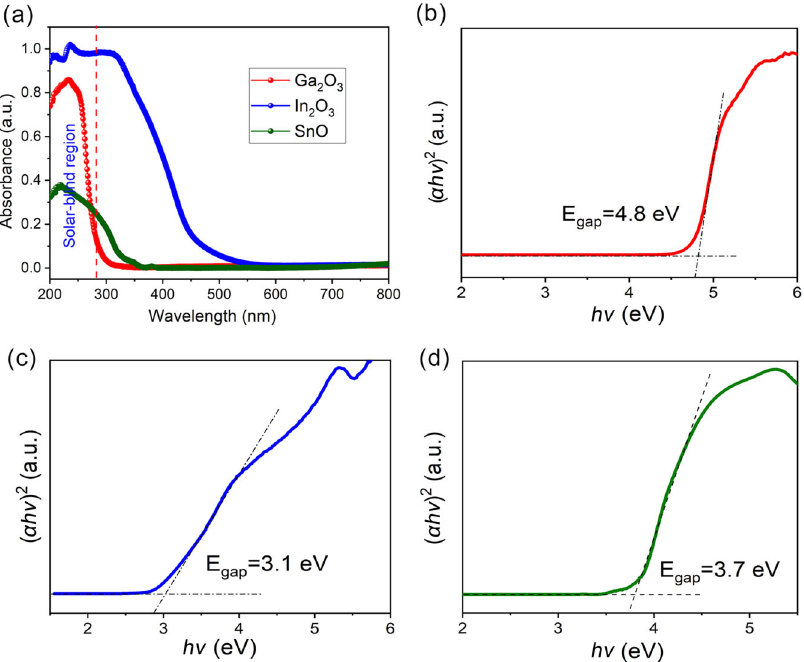
Fig. 3 The material properties and electronic band characterizations of printed 2D semiconductor. a The spectrum of the absorbance related to the printed Ga 2 O 3 , In 2 O 3 , and SnO fi lms. Tauc plot utilized in order to specify the electronic band gap for b Ga 2 O 3 , c In 2 O 3 and d SnO with a clari fi ed electronic band